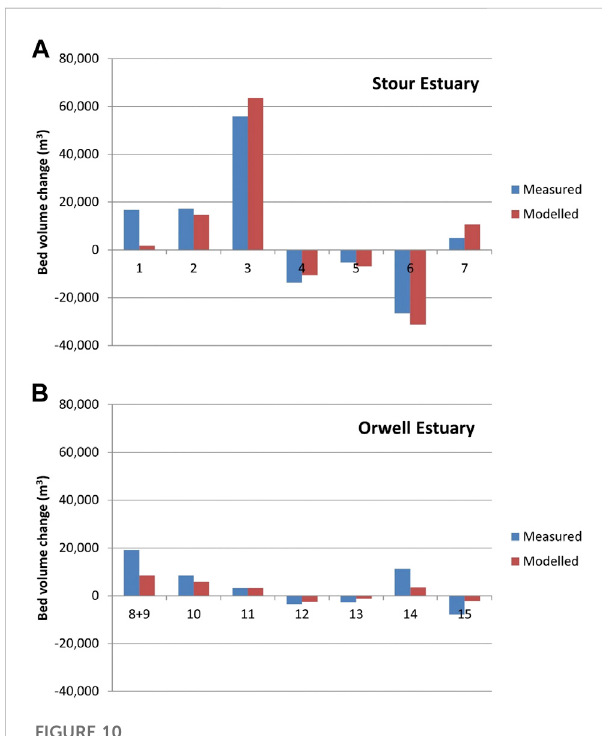
FIGURE 10 Comparison of the observed and predicted mean